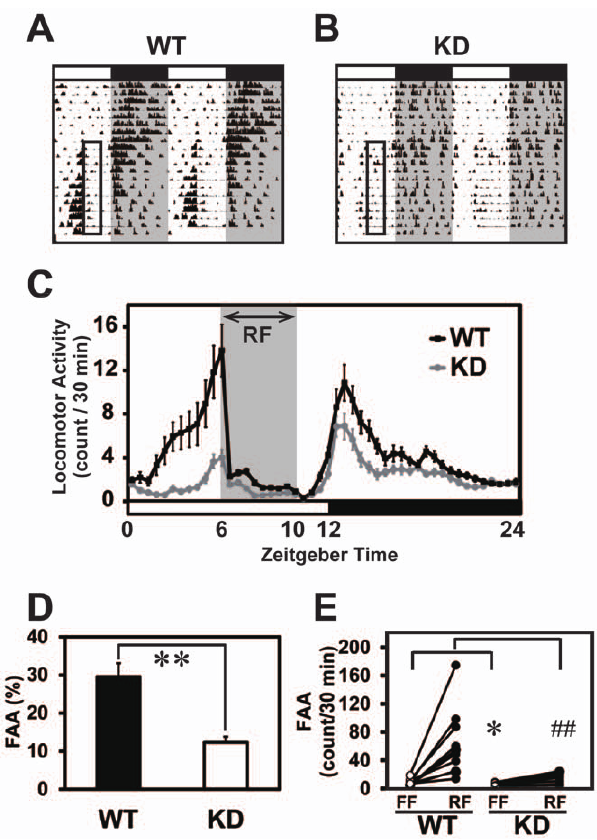
Figure 4. Attenuated FAA in the KD mice under daytime-RF. A, B, Examples of double-plotted actograms of WT (A) or KD (B) mice under RF. The RF time was set at ZT6–ZT10 (open box). Whereas WT mouse showed a strong FAA (A), those of KD were very weak (B). C, Averaged daily activity plot of the KD and WT mice under RF. D, Average percentages of FAA [100 6 activity counts (ZT2-6)/24-hour activity counts] during the last three days of RF between WT and KD mice were compared (n=11 each). ** P , 0.01 vs. WT (Student’s t -test). E, FAA counts of individual mice during 4 hours preceding RF (ZT2-6) averaged over the first 7 days of FF and the following 12 days of RF were compared in each genotype (n=11 each). * P , 0.05, vs. WT in FF; ## P , 0.01 vs. WT in RF (Student’s t -test).